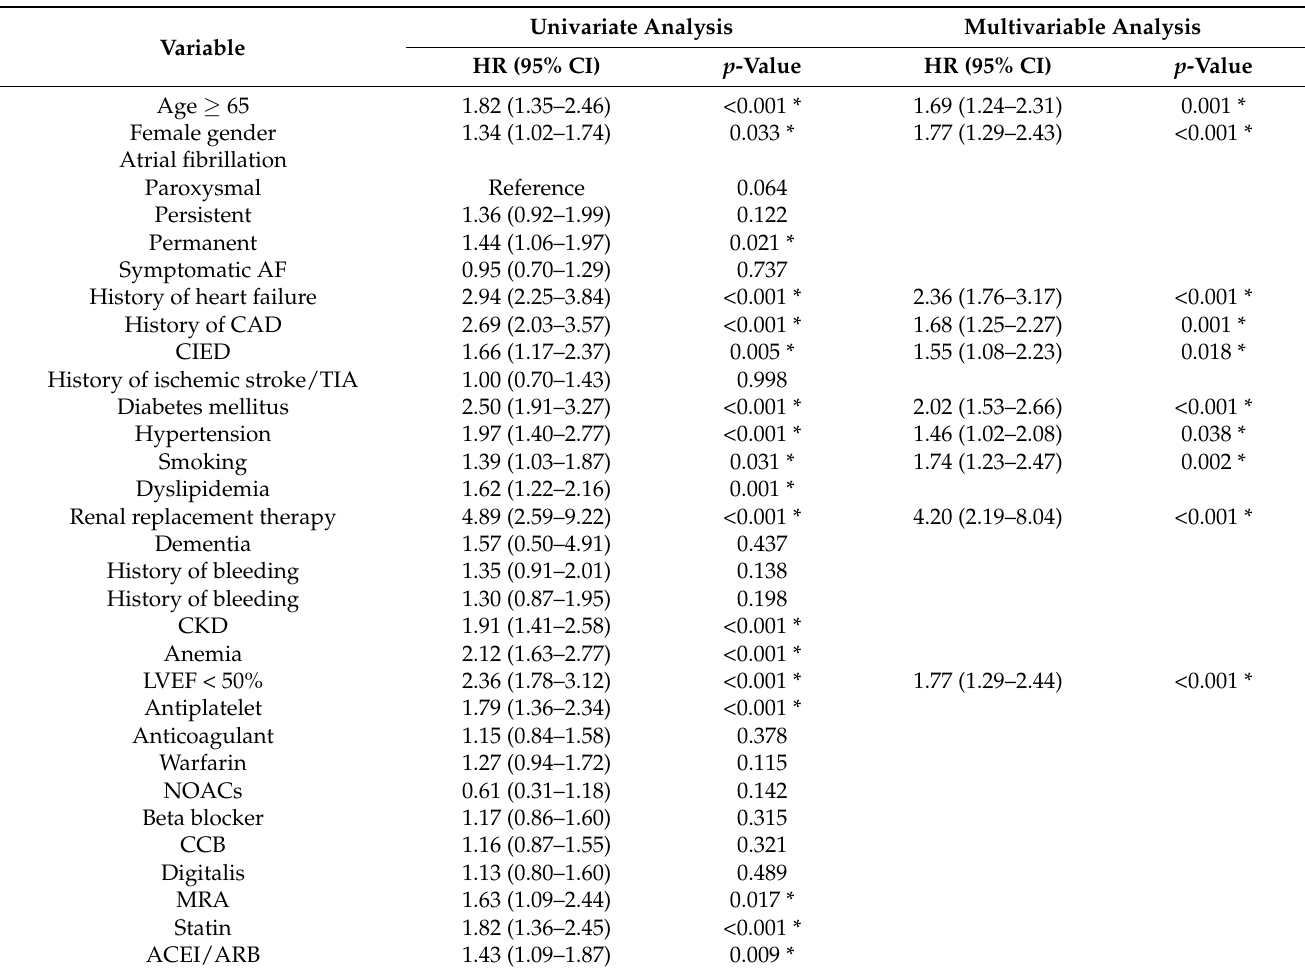
Table 2. Univariate and multivariable analysis of predicting factors for heart failure event. Univariate